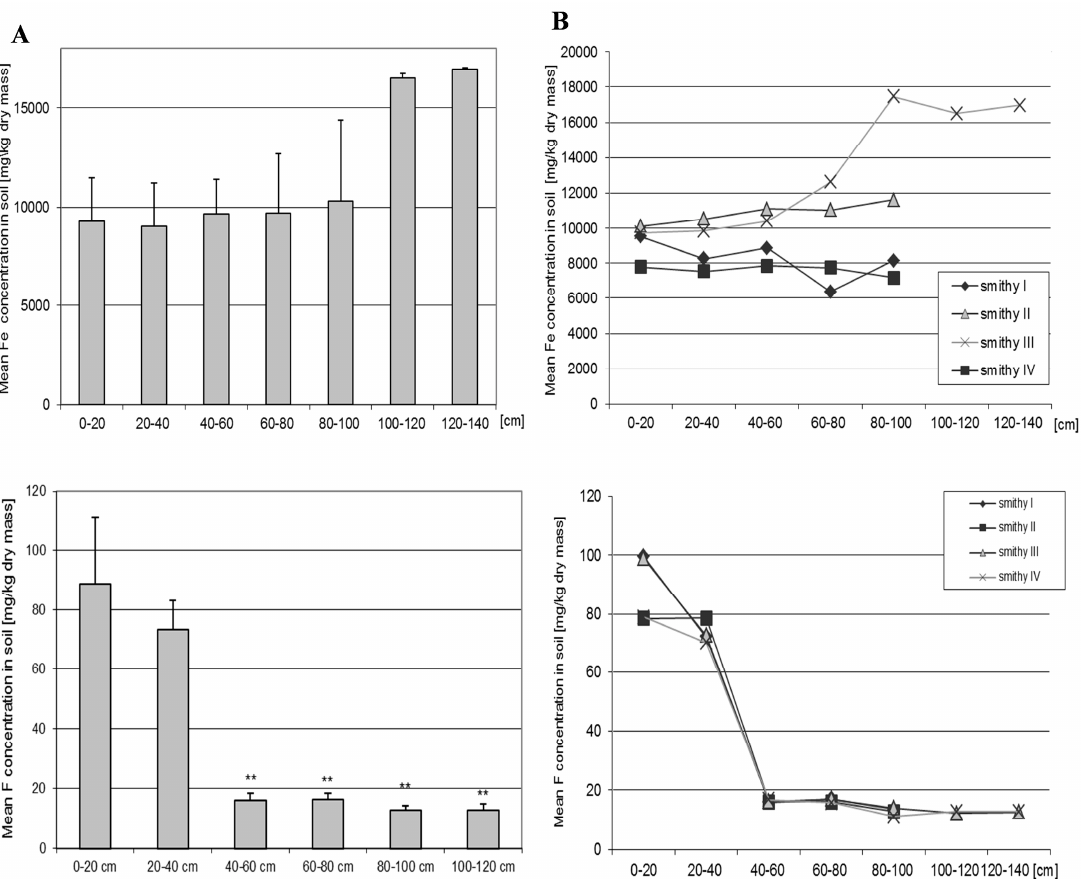
Figure 6. Mean concentration of Fe and F in the soil depending on the depth of sampling ( A ) and depending on the site and the depth of sampling ( B ). Data represent the means ± SD for 3 independent measurements. There is no statistically significant differences in Fe concentration depending on the depth of sampling (Mann-Whitney U test). ** p < 0.005 for the significance of difference marked depths vs 0-20cm and 20–40cm. Statistically significant differences depending on the site of sampling (Wilcoxon test), see Supplementary Table S2.